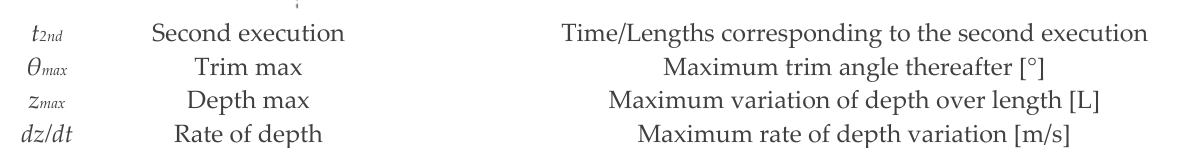
Figure A2. Meander test time-series and characteristics.